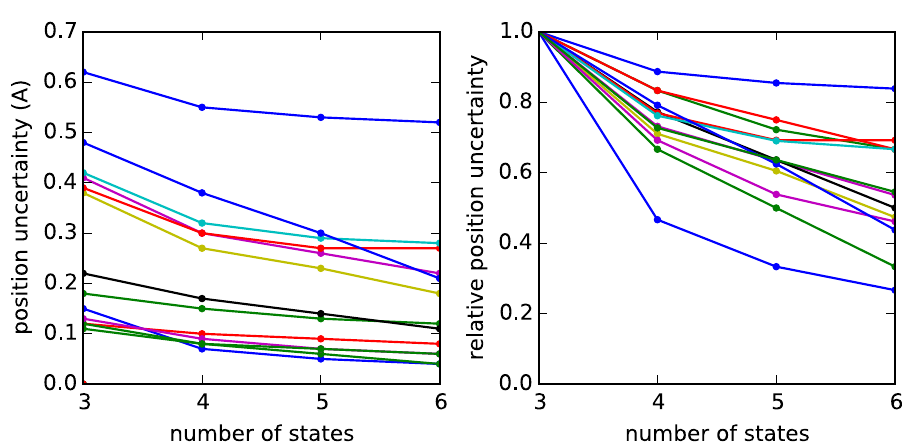
Fig 2. Error in the position as a function of the number of side chain states, resulting from a decomposition of rotamer states into coarse-grained states. The table summarizes the number of states chosen for each amino acid type. The relative uncertainty is the positional uncertainty for each number of states divided by the accuracy at three states. One, three, or six rotamer states are used, depending on the residue type. For residues without a rotatable χ 2 , such as valine, only three states are needed. The time to compute the pairwise interactions and solve for the free energy scales roughly as the number of coarse rotamer states squared, so the use of fewer coarse states is preferred. Ile, Leu and Lys are the three residues with rotatable χ 2 where only 3 states are assigned.